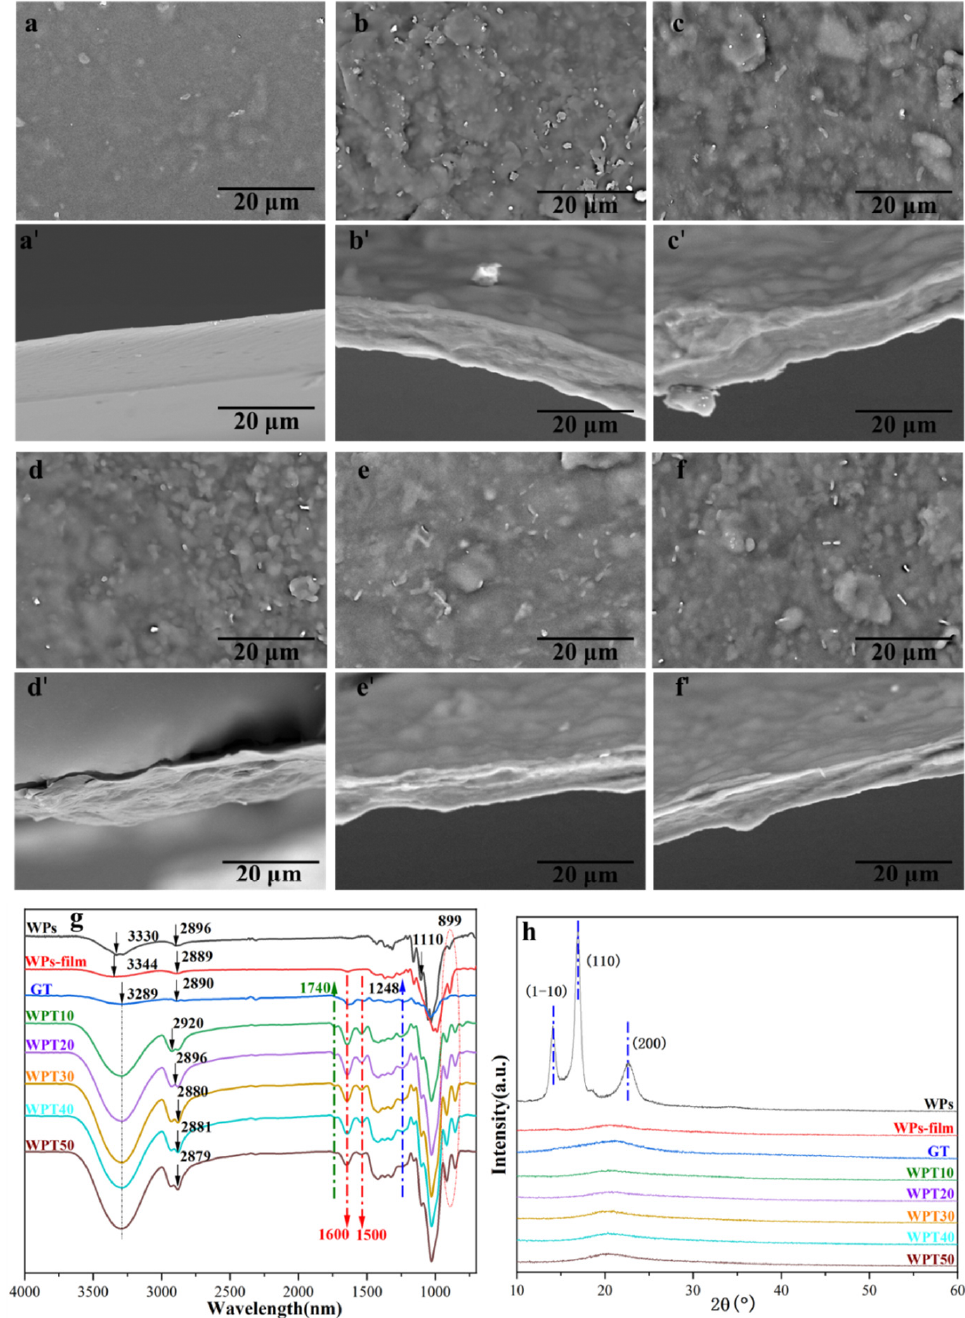
Figure 5. SEM micrographs of the regenerated films: ( a – f ) the surface and ( a’ – f’ ) the cross section of WPs-film, WPT10, WPT20, WPT30, WPT40 and WPT50; ( g ) FTIR; and ( h ) XRD profiles of WPs, WPs-film, GT, WPT10, WPT20, WPT30, WPT40 and WPT50.